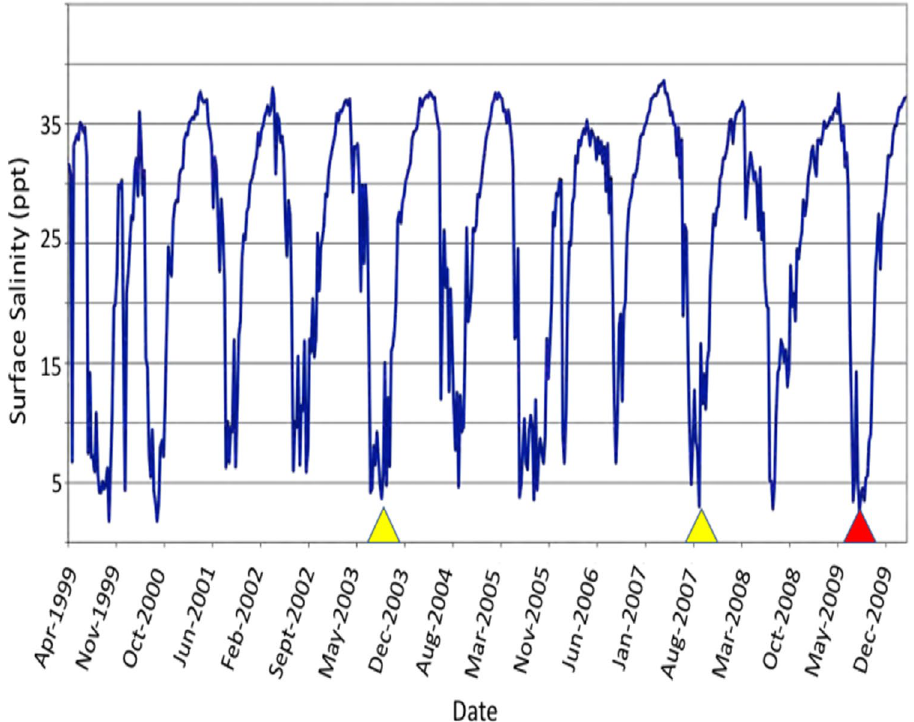
Figure 11. Surface (0.5 M depth) salinity at the Narrows Bridge in the Swan-Canning Riverpark from 1999 through 21st Dec. 2009 showing marked annual seasonal declines in salinity from late austral winter through spring. Confirmed (red arrowhead) and suspected (yellow) freshwater skin disease cases in resident bottlenose dolphins. Prepared by the Department of Water and Environmental Regulation for the Department of Biodiversity, Conservation and Attractions, Western